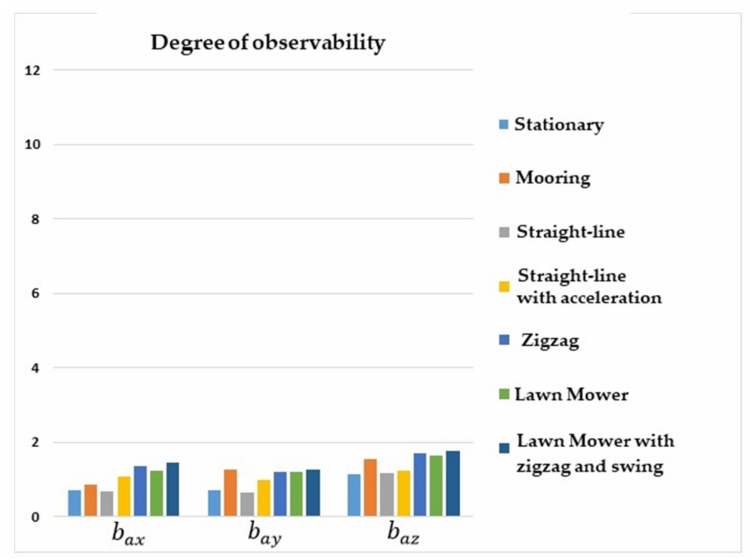
Figure 7. Degrees of observability of the accelerometer biases. INS/DVL/PS integration.